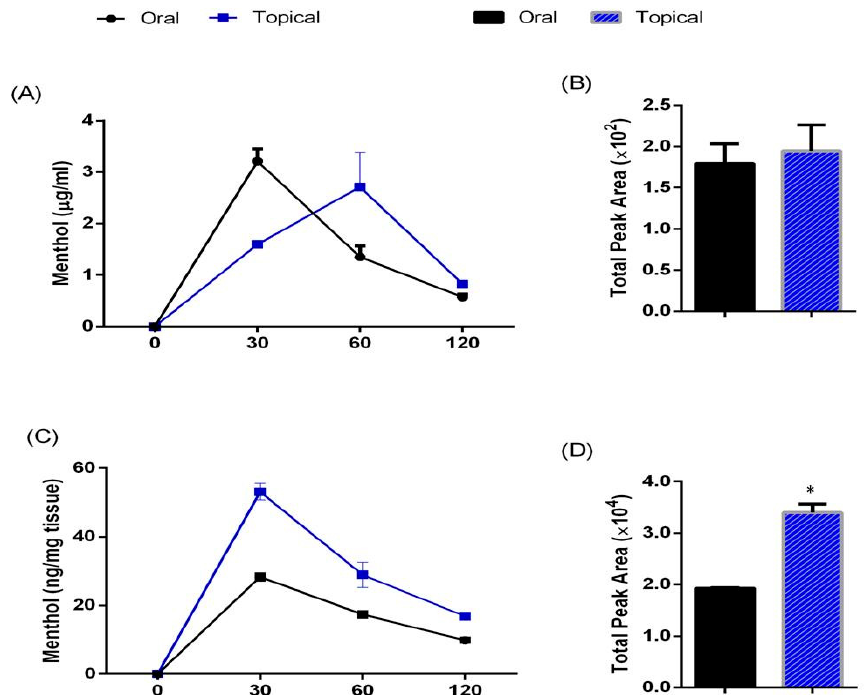
Figure 1. Pharmacokinetic of menthol administration upon oral and topical administration( A ) Time dependent changes in serum concentration of menthol; ( B ) Area under the time-concentration curve in serum of menthol treated mouse; ( C ) Time dependent changes in concentration of menthol in subcutaneous adipose tissue; ( D ) Area under the time-concentration curve in subcutaneous adipose tissue of menthol treated mice. Oral- Single dose of oral menthol administration at 200 mg / kg. Topical-Single dose of topical menthol application at 10% concentration (300 µ L / animal). n = 3. All the values are expressed as mean ± S.E.M; * p < 0.05.